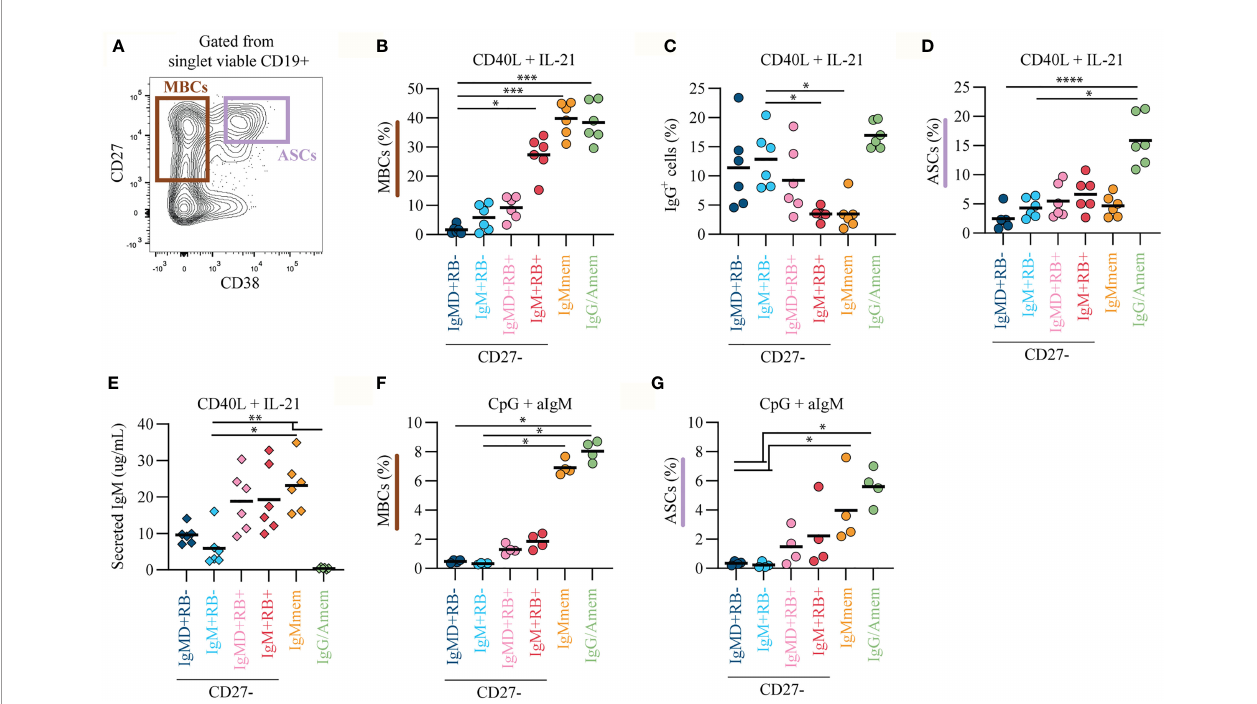
FIGURE 3 | CD45RB glycosylation, combined with Ig isotype, marks functionally distinct B cell subsets. B cell subsets were cultured with TD-stimulation of CD40L- expressing 3T3s in the presence of IL-21 (50ng/ml) for 10 days (six biological replicates each consisting of two technical replicates over two independent experiments). (A) Representative biaxial CD27/CD38 FACS plot after 10 days of TD culture. The formation of (B) MBCs (CD27+CD38-) (C) IgG+ B cells, and (D) ASCs (CD27+CD38+) was measured using fl ow cytometry. (E) Cumulative IgM secretion measured in culture supernatants using ELISA at day 10 (n = 6). B cell subsets were cultured with TI- stimulation of CpG ODN (0.1 m M) and anti-IgM-F(ab ’ ) 2 (1 m g/ml) for 7 days (four biological replicates each consisting of two technical replicates). The formation of (F) MBCs and (G) ASCs was measured using fl ow cytometry. Black lines depict mean values. Statistical differences were determined using a Friedman analysis of variance and